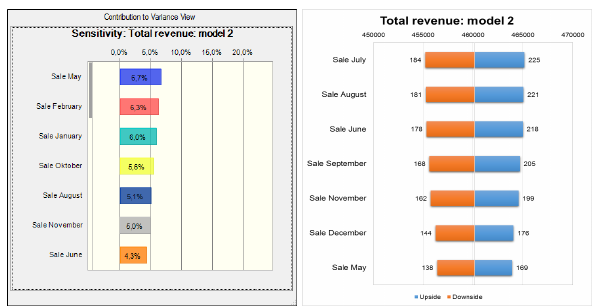
Figure 10: Sensitivity chart and tornado chart for total revenue per year: model